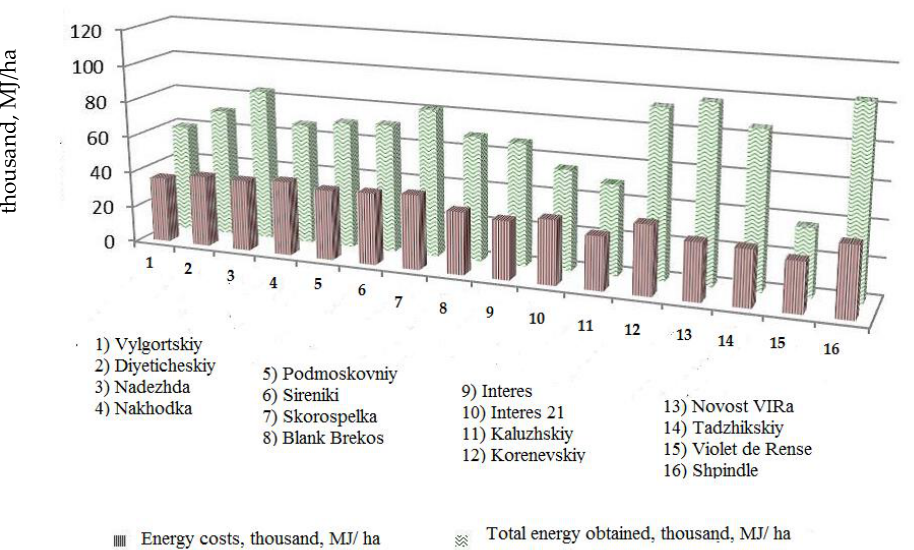
Figure 8. Economic efficiency of Jerusalem artichoke cultivation.